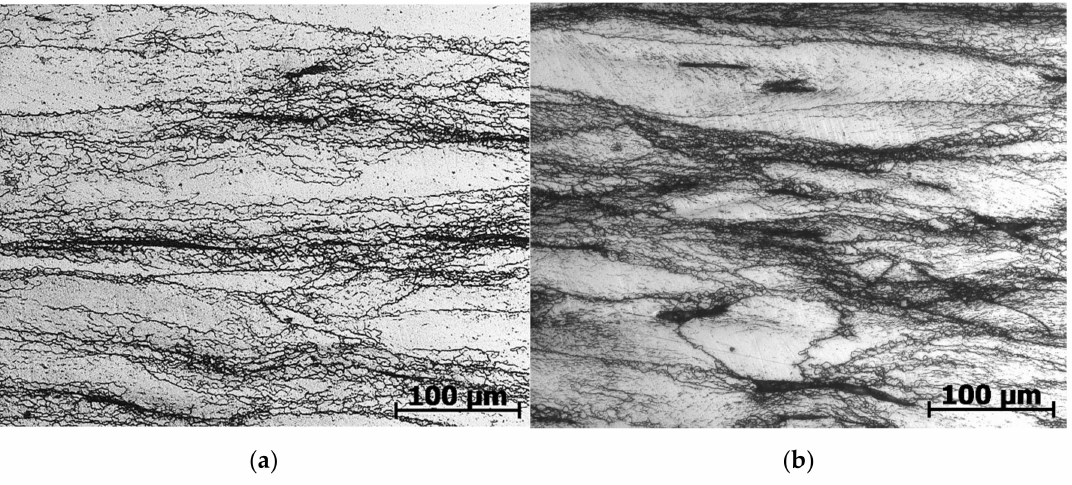
Figure 3. Microstructure of AISI 321 steel after hot deformation at 1000 ◦ C: ( a ) with strain rate 0.01 s − 1 ; ( b ) with strain rate 0.1 s − 1